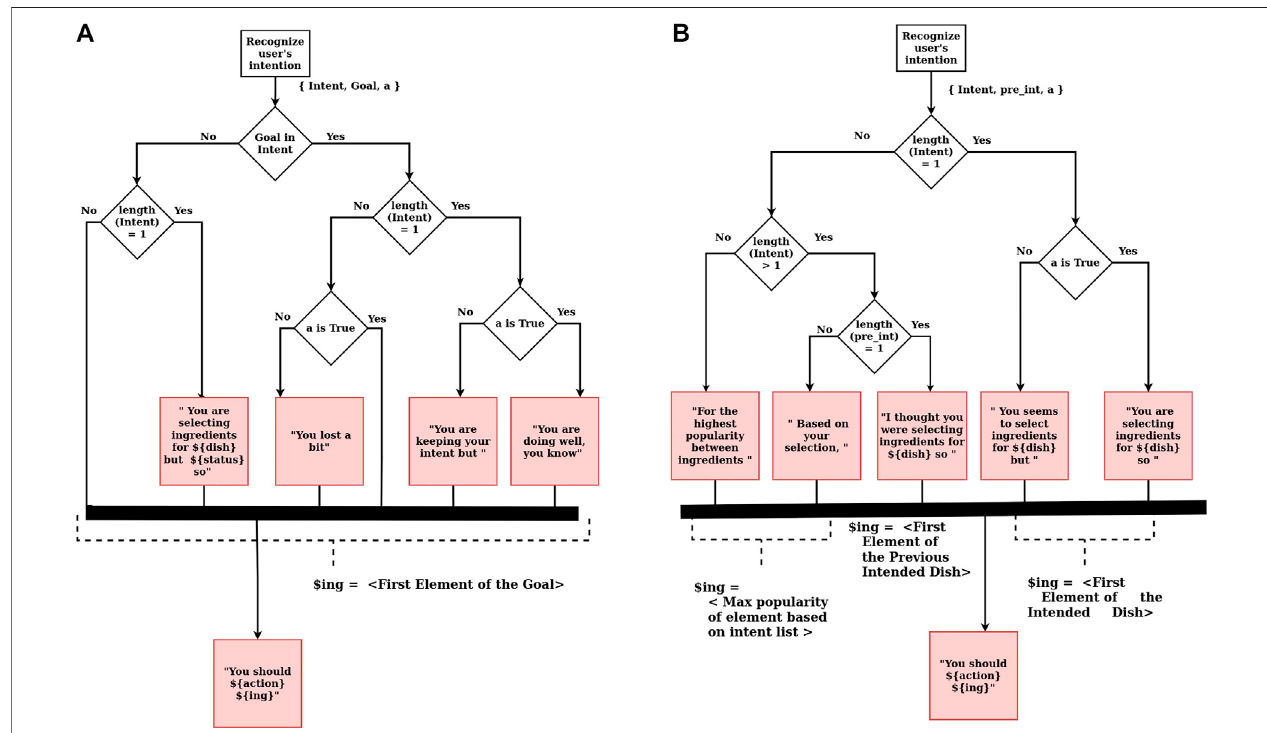
FIGURE2| Diagramofproactiverobotcommunicativeisshowinghowproactivesuggestionsareinitiated.Itisstartingwithrecognizingtheuser ’ sintention.Thelist oftheuser ’ sintentpassestothereasoningmechanismwhichisbasedonlayersofrules.Redboxesshowtherobotresponse.Inboxes,thetemplateisgiventocreatea sentence. Between curly brackets of $ { ... } fi lled with symbolic representation of action (${action}), object – ingredient (${ing}) or dish (${dish}) – or the result of system (${status}). Each box concatenates to each other on the road to create proactive behavior of the robot.